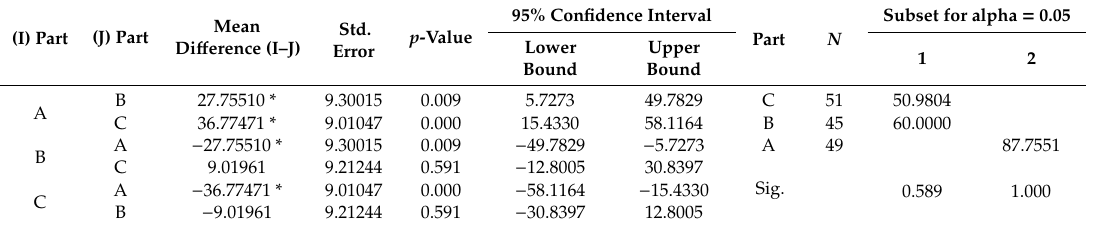
Table 12. Tukey cognitive maps analyses in the three investigated intersections (A, B and C).